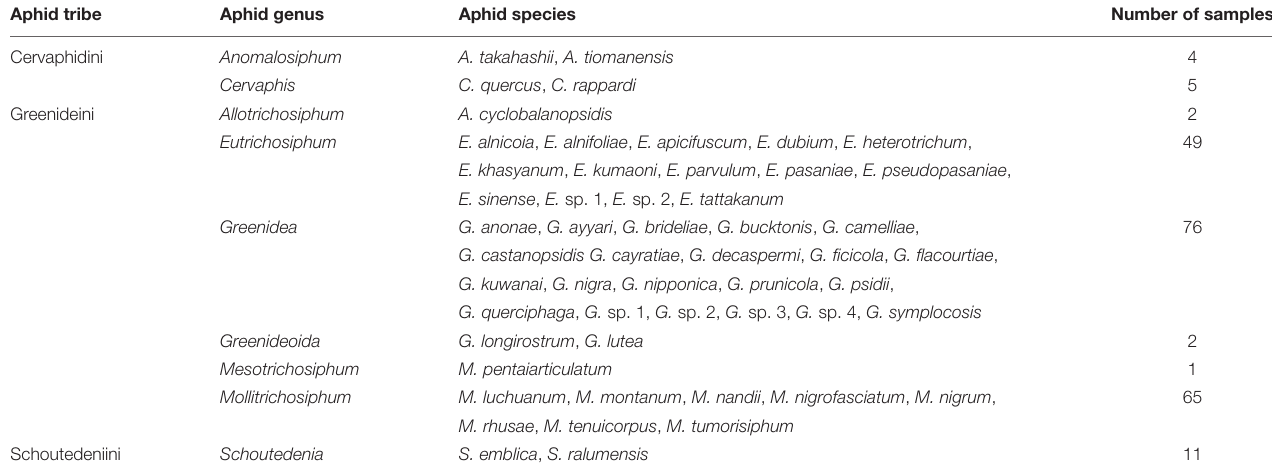
TABLE 1 | Sampling information for the Greenideinae samples used in the present